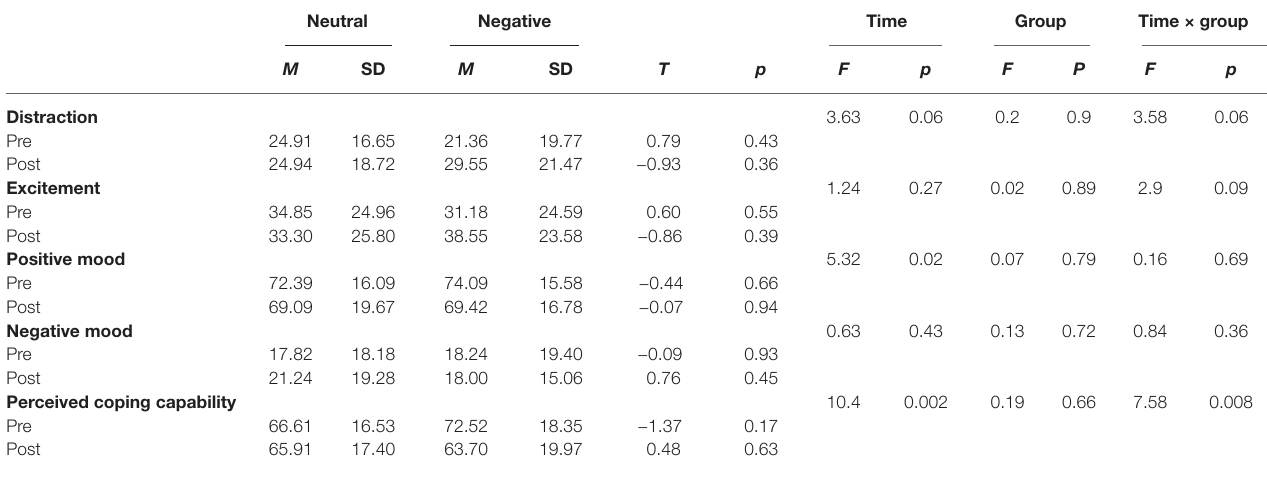
TABLE 1 | Descriptive and test statistics for the five VAS